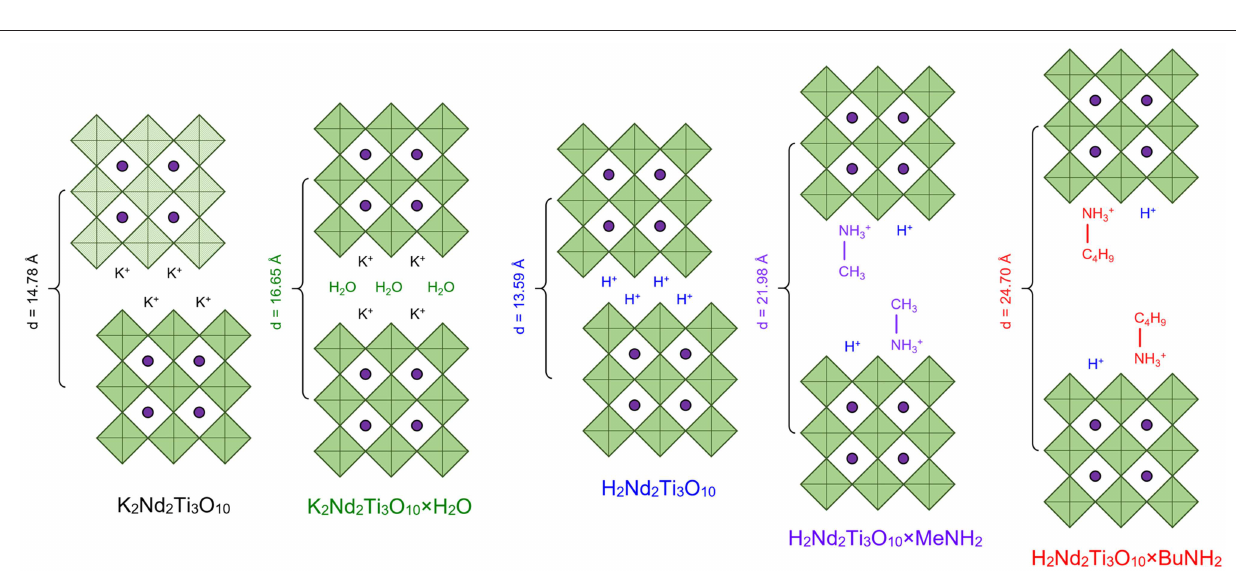
to explain such complex behavior, STA-MS was carried